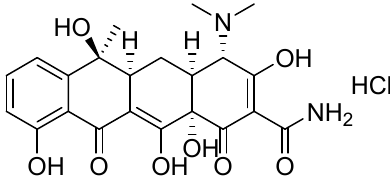
Figure 1. structure of tetracycline hydrochloride. Figure 1. Structure of tetracycline